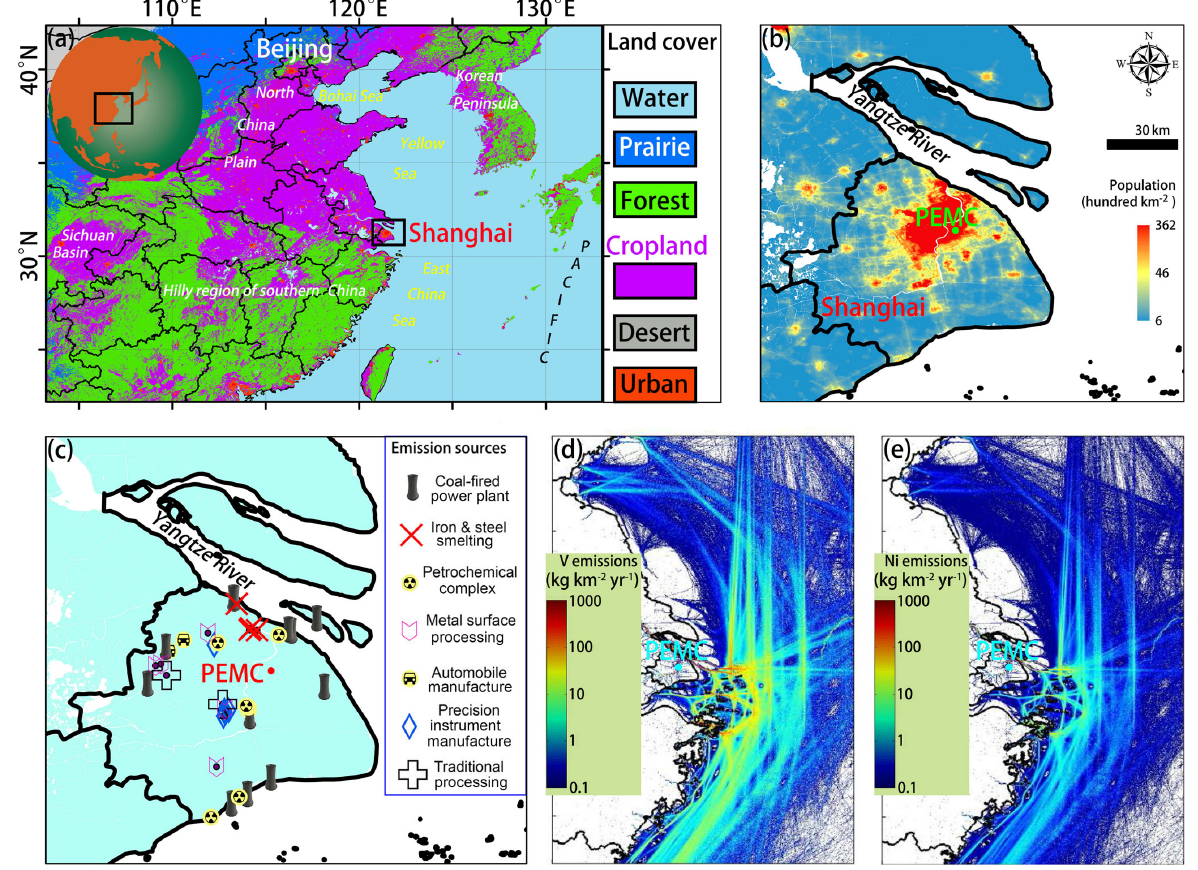
Figure 1. Land use map indicating the location of Shanghai ( a ; black box), as well as the population density (b) and the major point sources (c) around the sampling site (PEMC). The emissions of V (d) and Ni (e) from shipping in the YRD and the East China Sea within 400km of the coastline were estimated based on an automatic identification system model (adopted from Fan et al.,